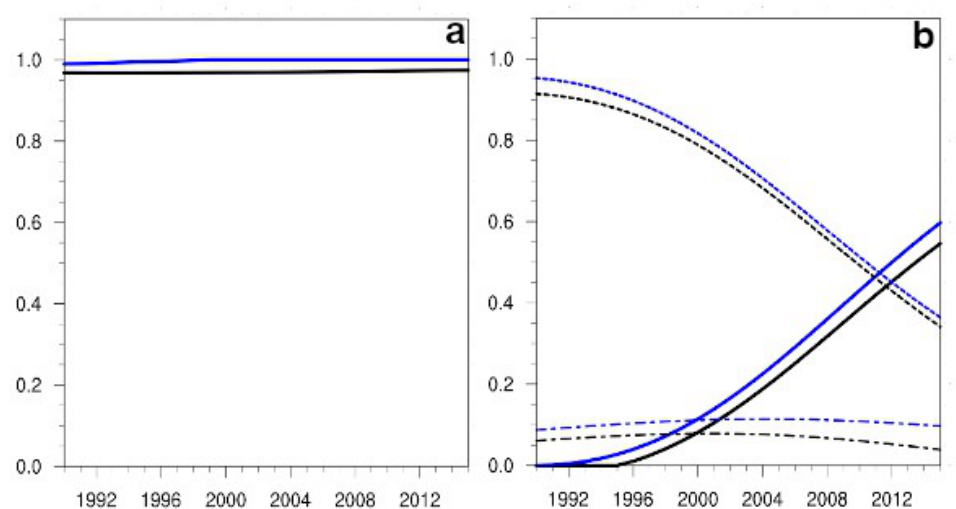
Figure 5. ( a ) Projection in time of the Sobol sensitivity indices, S i and S iT , for the variable passengers, in the case of Intra-European flights (L) with β values in the interval (0.1, 3.5). Colour codes and line styles are the same as in Figure 4a. ( b ) The evolution in time of the Sobol sensitivity indices, S i and S T , for the emissions variable with the colour codes and line styles of Figure i